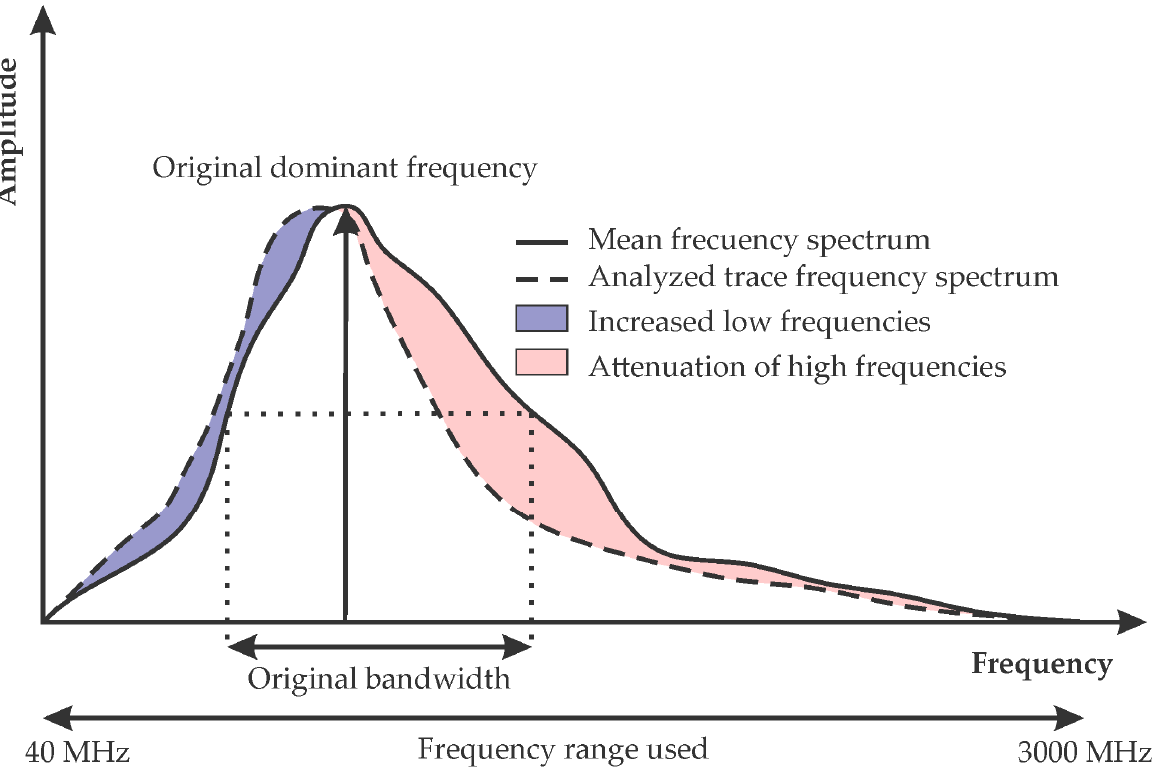
Figure 1. Diagram of the typical frequency spectrum in GPR and of the two parameters analyzed in this study. this